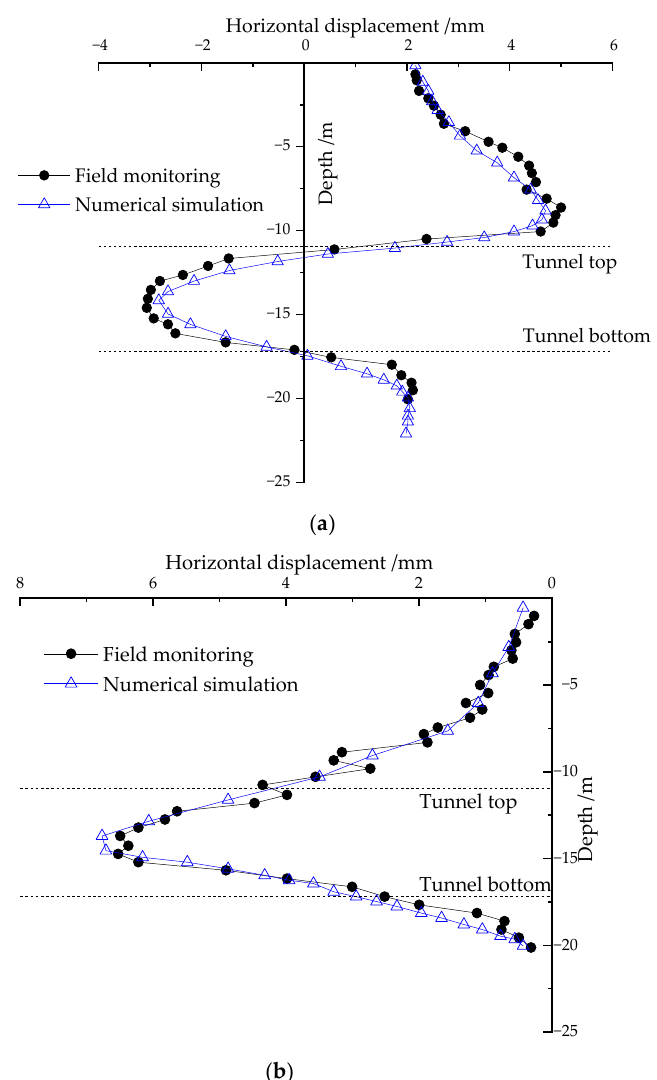
Figure 6. Horizontal displacement of surrounding soil from field monitoring and numerical simulation: ( a ) outer side of curved tunnel axis; ( b ) inner side of tunnel.